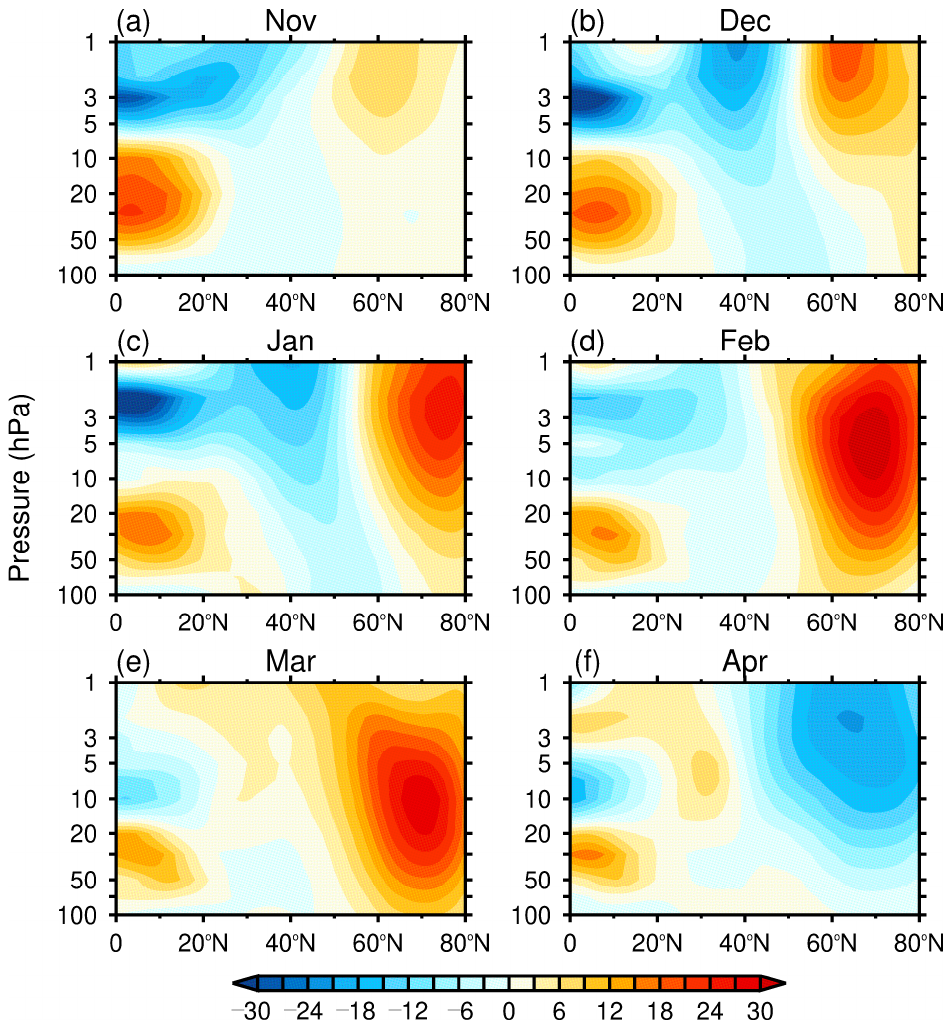
Figure 8. Month ‐ to ‐ month evolution of zonal ‐ mean wind anomalies ( a – f ) from November 2010 to Figure 8. Month-to-month evolution of zonal-mean wind anomalies ( a – f ) from November 2010 to April 2011. Anomalies are defined as the deviations of zonal ‐ mean wind from its seasonal cycle. April 2011. Anomalies are defined as the deviations of zonal-mean wind from its seasonal